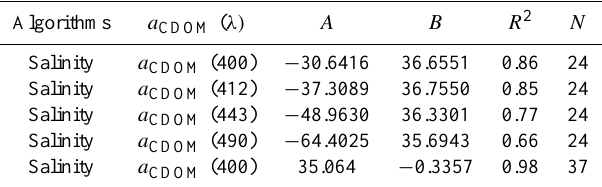
Table 2. Parameters for the estimation of salinity (psu) from the a CDOM ( λ)